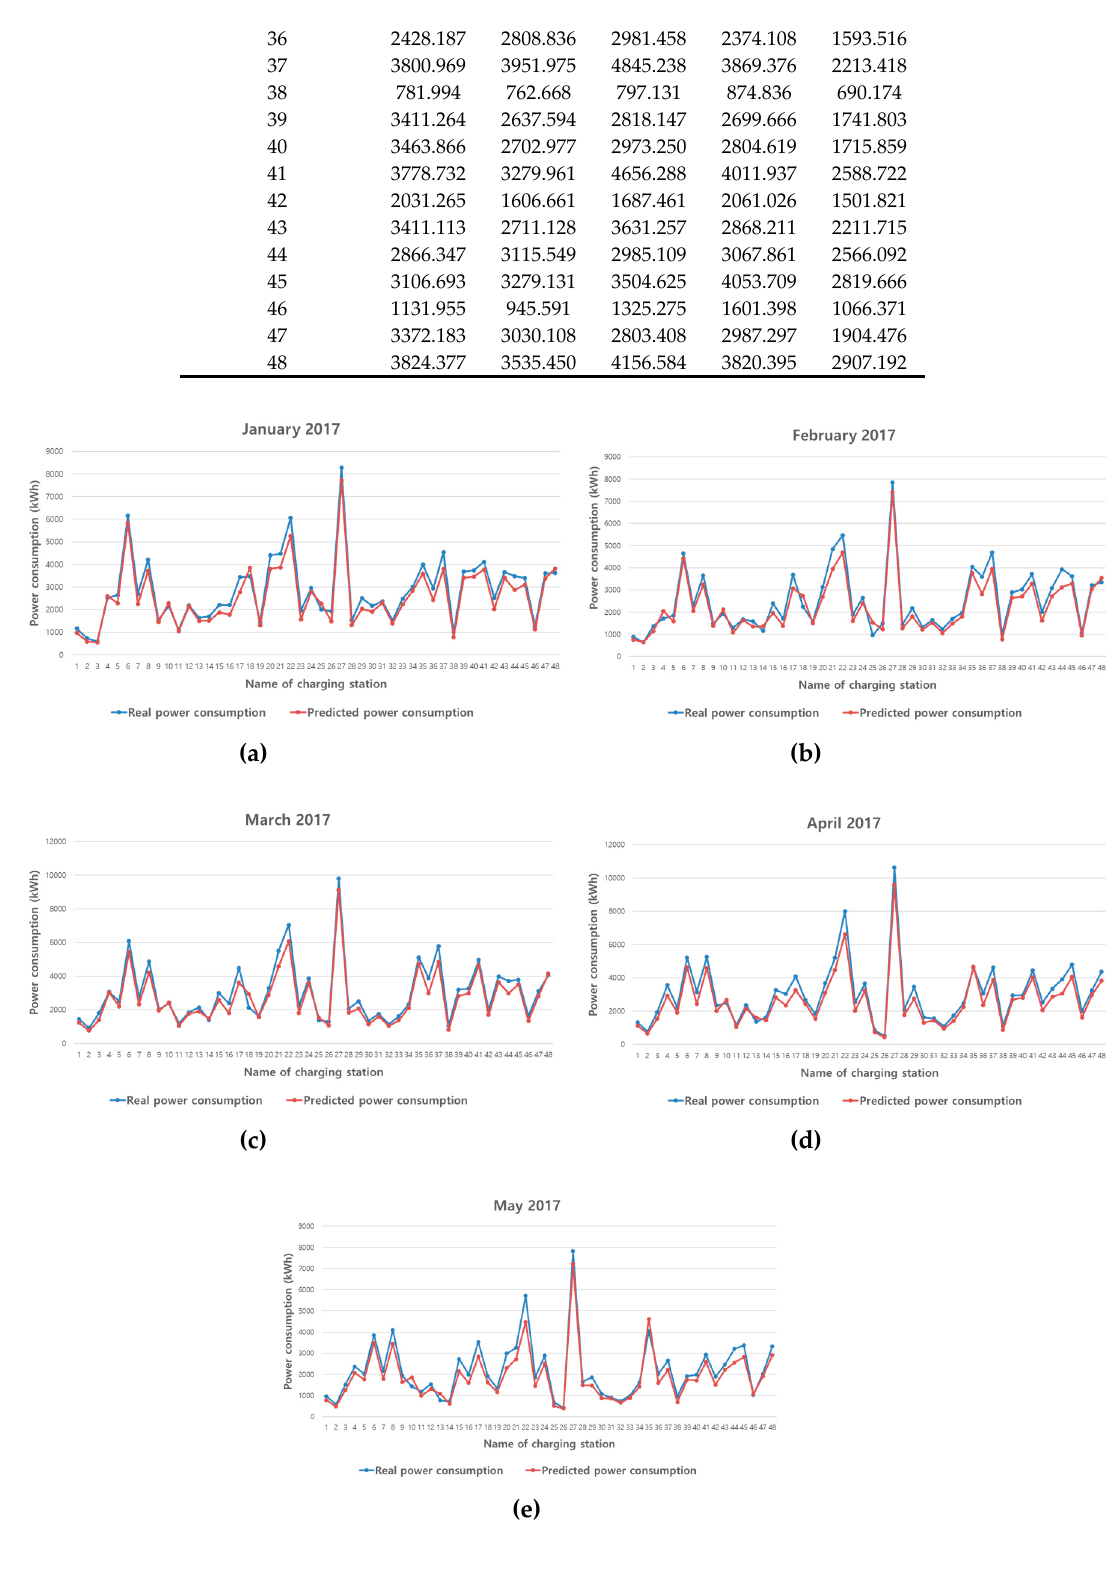
Figure 10. Comparison of real and predicted power consumption for EV charging stations: (a) January 2017; (b) February 2017; (c) March 2017; (d) April 2017; (e) May